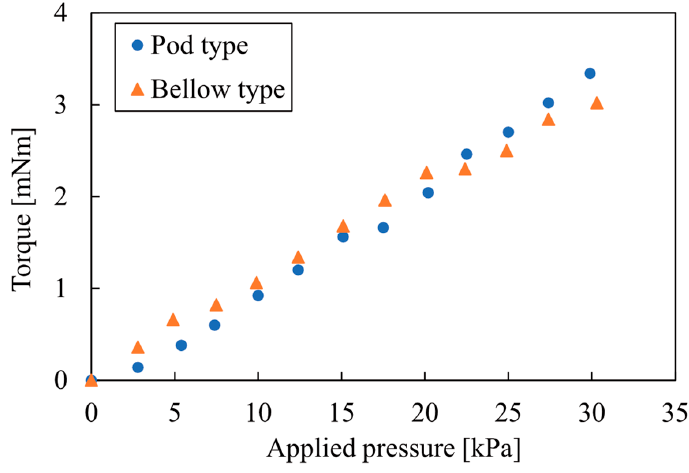
Figure 17. Relationship between pressure and generated torque of the two types of actuators.